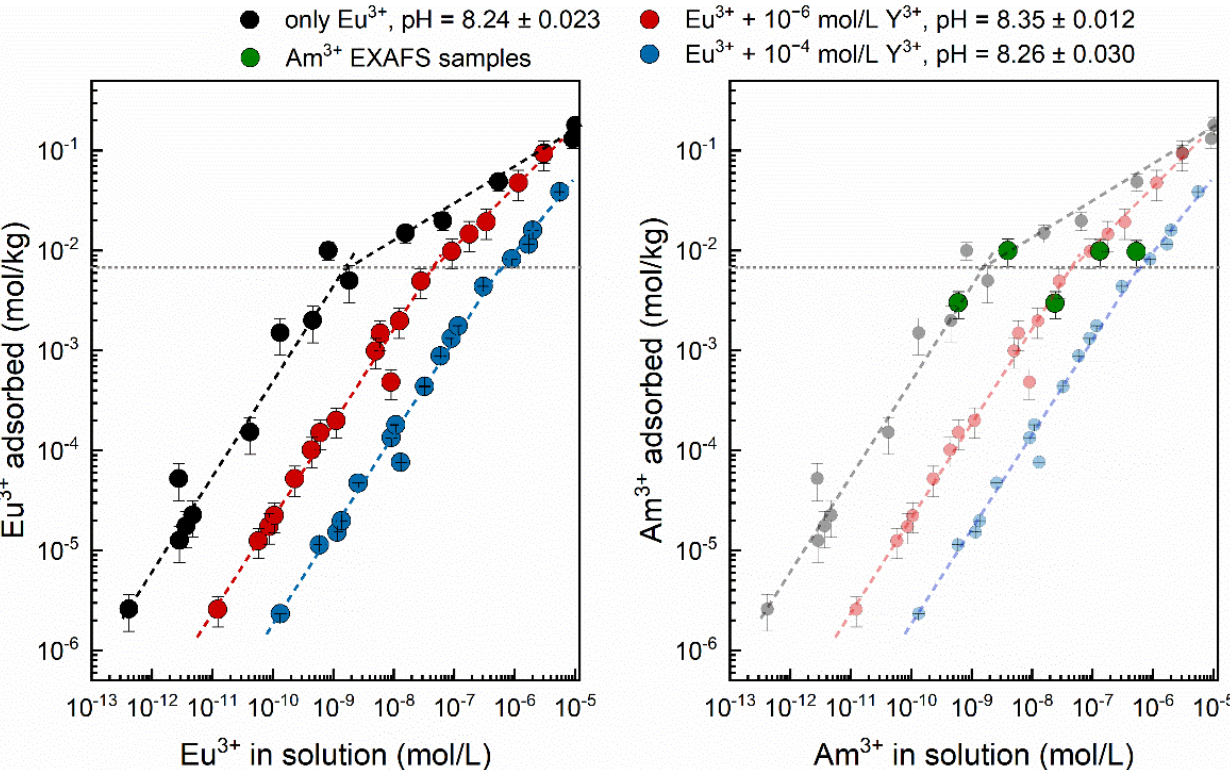
Figure 3. ( Left ): isotherm results for Eu 3+ adsorption on 0.5 g/L corundum in the absence (black symbols) and presence of 10 − 6 mol/L (red symbols) and 10 − 4 mol/L Y 3+ (blue symbols). The gray horizontal line indicates where the slope of the isotherm changes from one (1) to <1. The error given for the pH values is the standard deviation (1 σ ) of all sample pH values in one isotherm experiment. ( Right ): EXAFS samples (green symbols) containing Am 3+ or Am 3+ + Y 3+ on 2.0 g/L corundum, displayed together with the Eu 3+ isotherms (washed out symbols). For the pH values of these samples, the reader is referred to in Table 1.